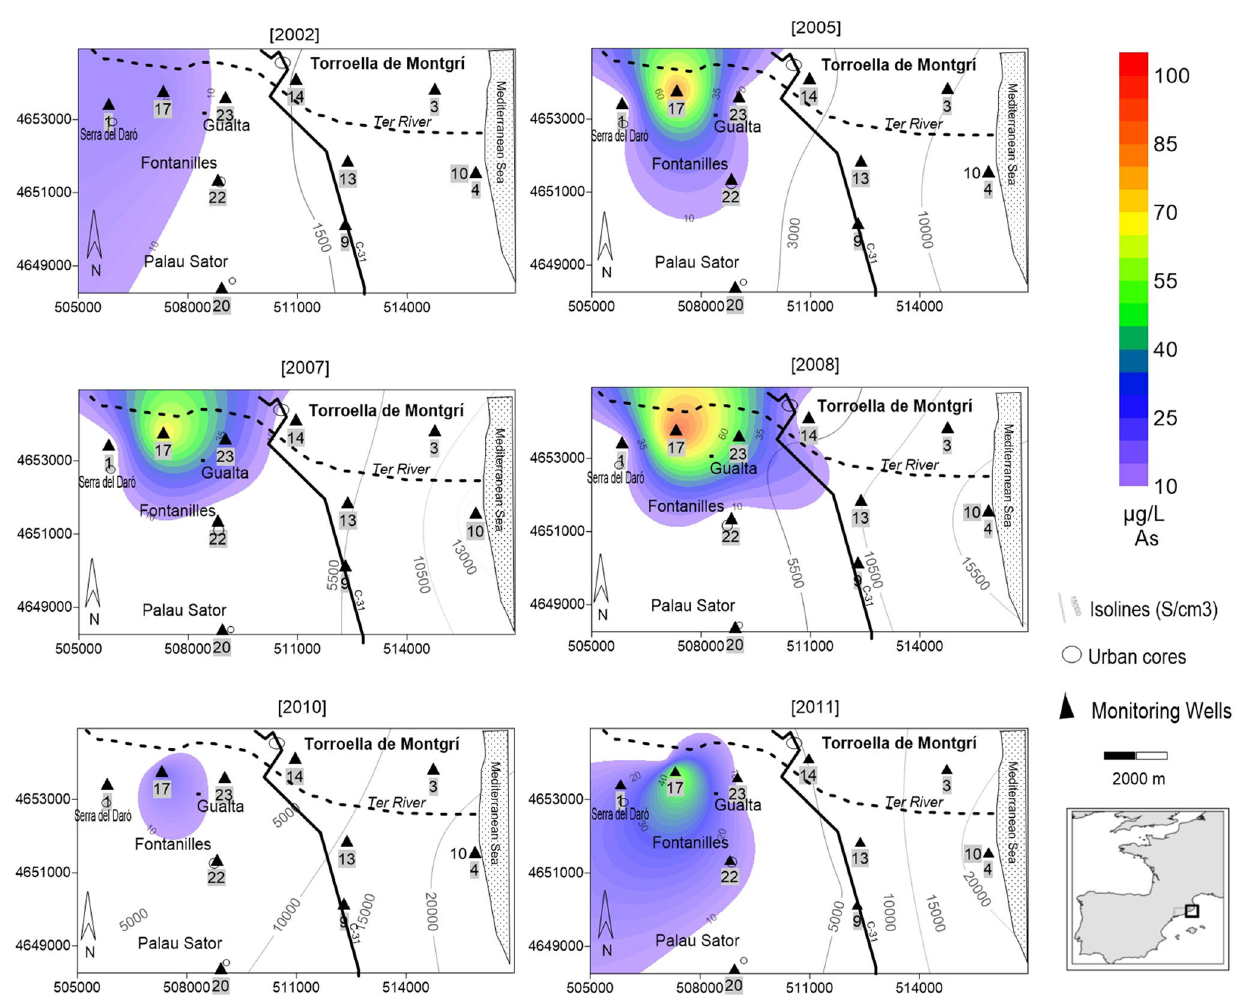
Fig. 3 Arsenic concentrations in